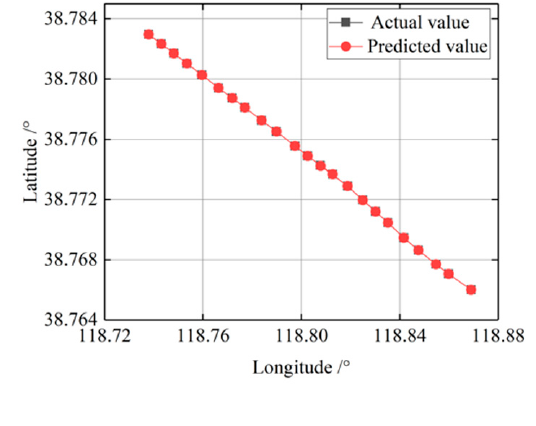
Figure 8. Prediction results of a-trajectory using the ACDE-SVR model. ( a ) Comparison of predicted and actual values of a-trajectory; ( b ) Longitude and latitude absolute error values of a-trajectory.